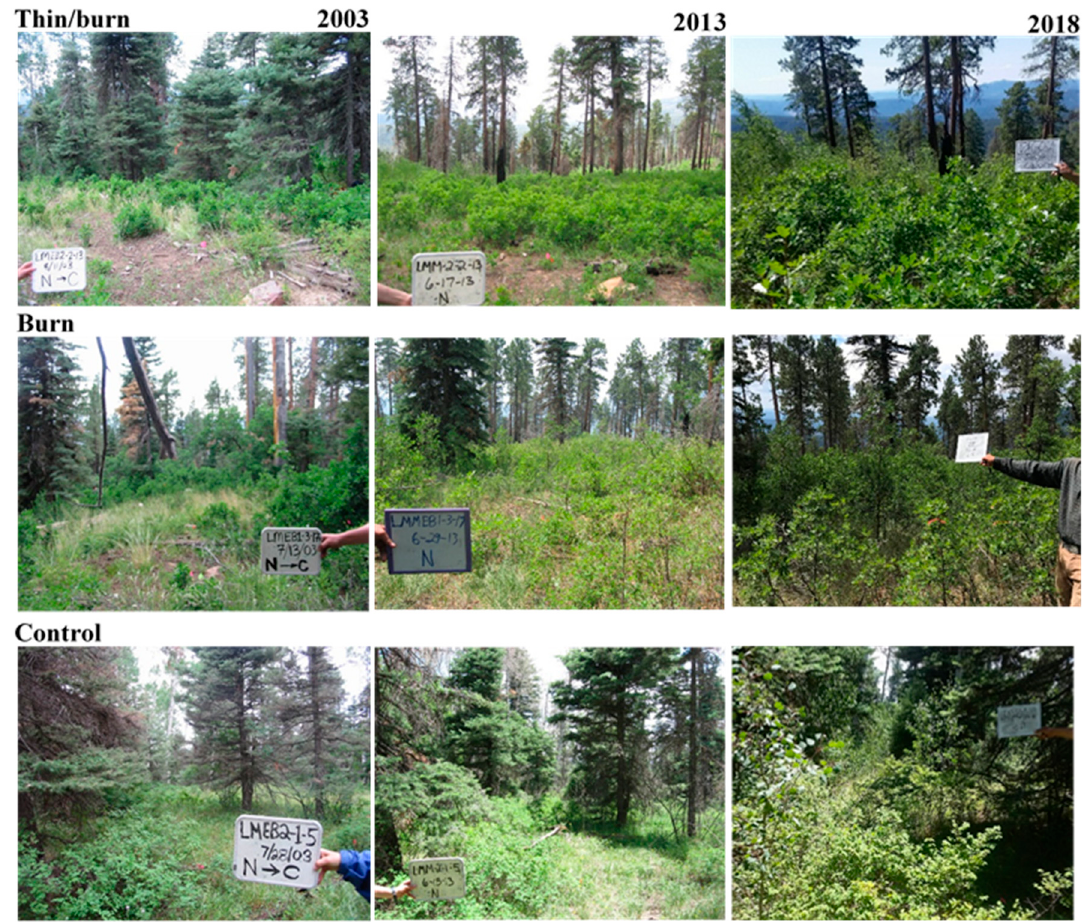
Figure 8. Repeat photos taken from alternative restoration treatments before treatment (2003), 5 years after treatment (2013), and 10 years after (2018).